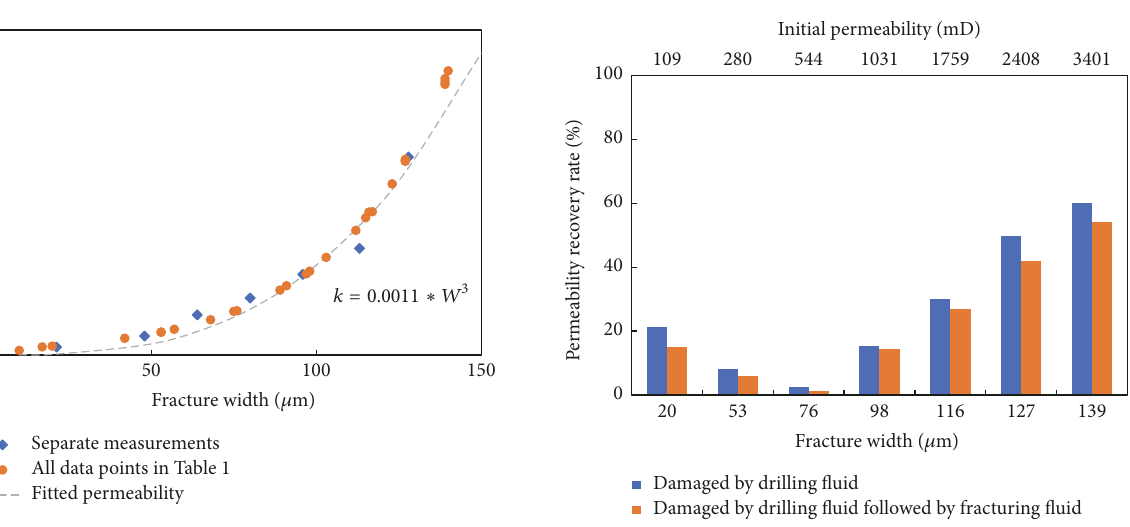
Figure 8: Permeability damage due to drilling and fracturing fluids (core samples